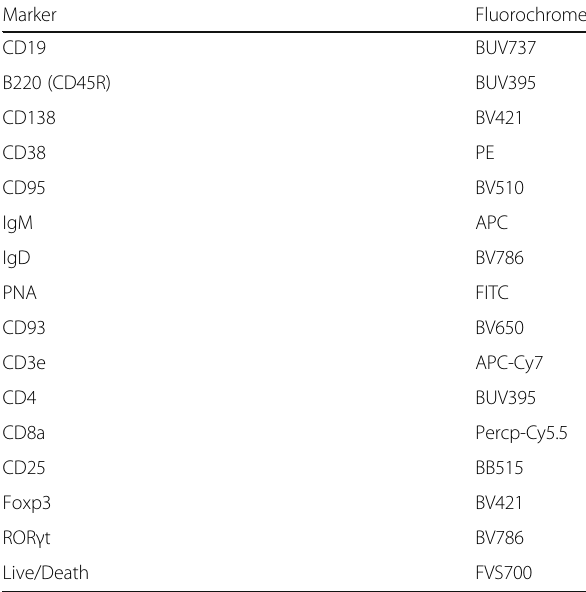
Table 2 Antibodies used for flow cytometry experiments. All antibodies were from BD Bioscience